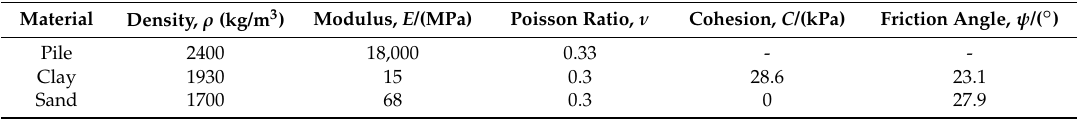
Table 1. Physical and mechanical parameters of soil and pile.